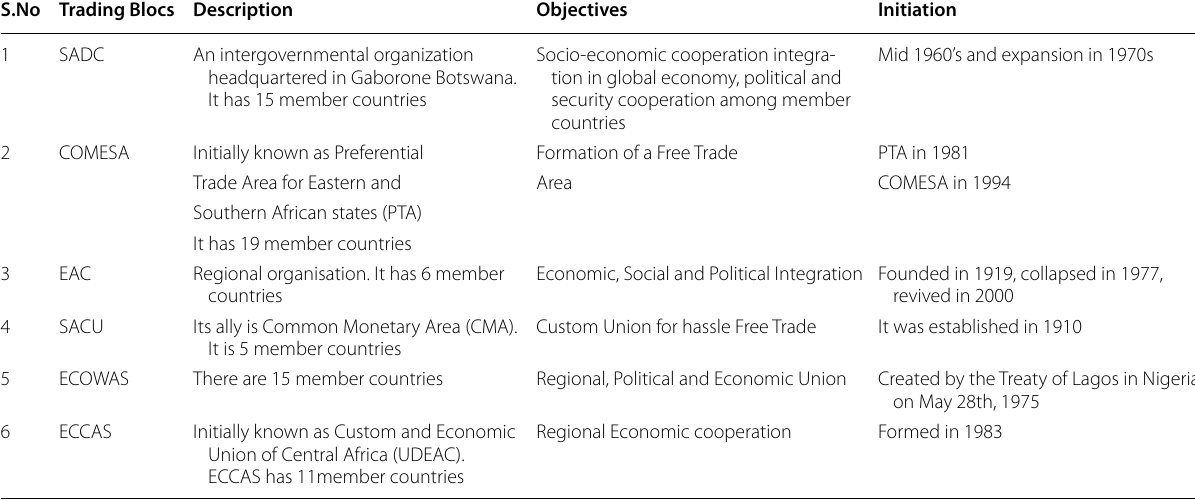
Table 1 Regional economic communities of Trade Blocs in Africa. Source : Prepared by the authors from various sources. SADC‑ Southern African Development Community, COMESA‑Common Market for Eastern and Southern Africa, EAC‑East African Community, SACU‑Southern African Customs Union (SACU), ECOWAS‑Economic Community of West African States and ECCAS‑Economic Community of Central African